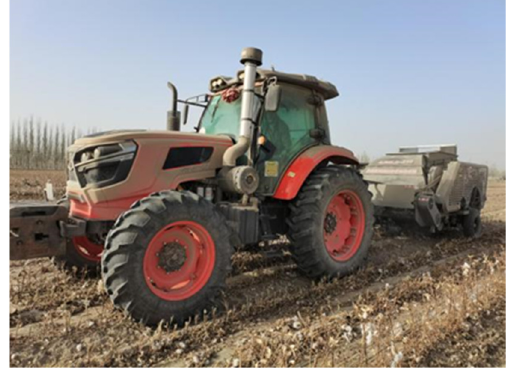
Figure 12. Farm tractor and experimental machine.